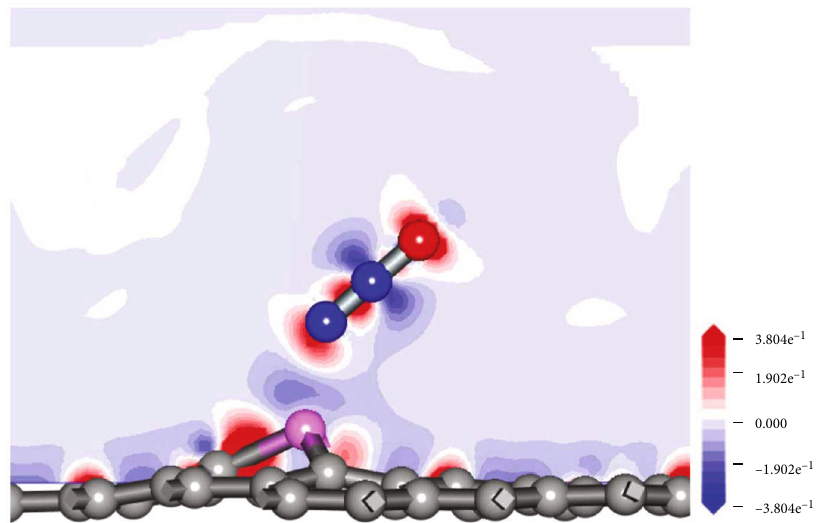
Figure 10: The charge di ff erence density of N